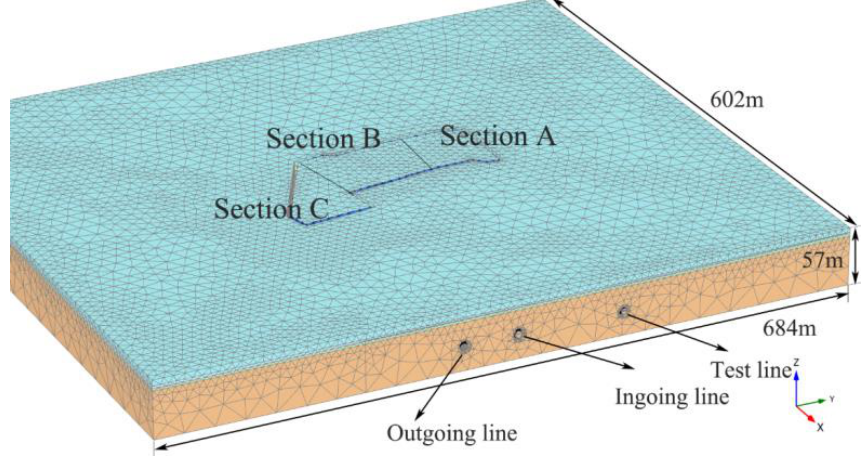
Figure 4. The model mesh.